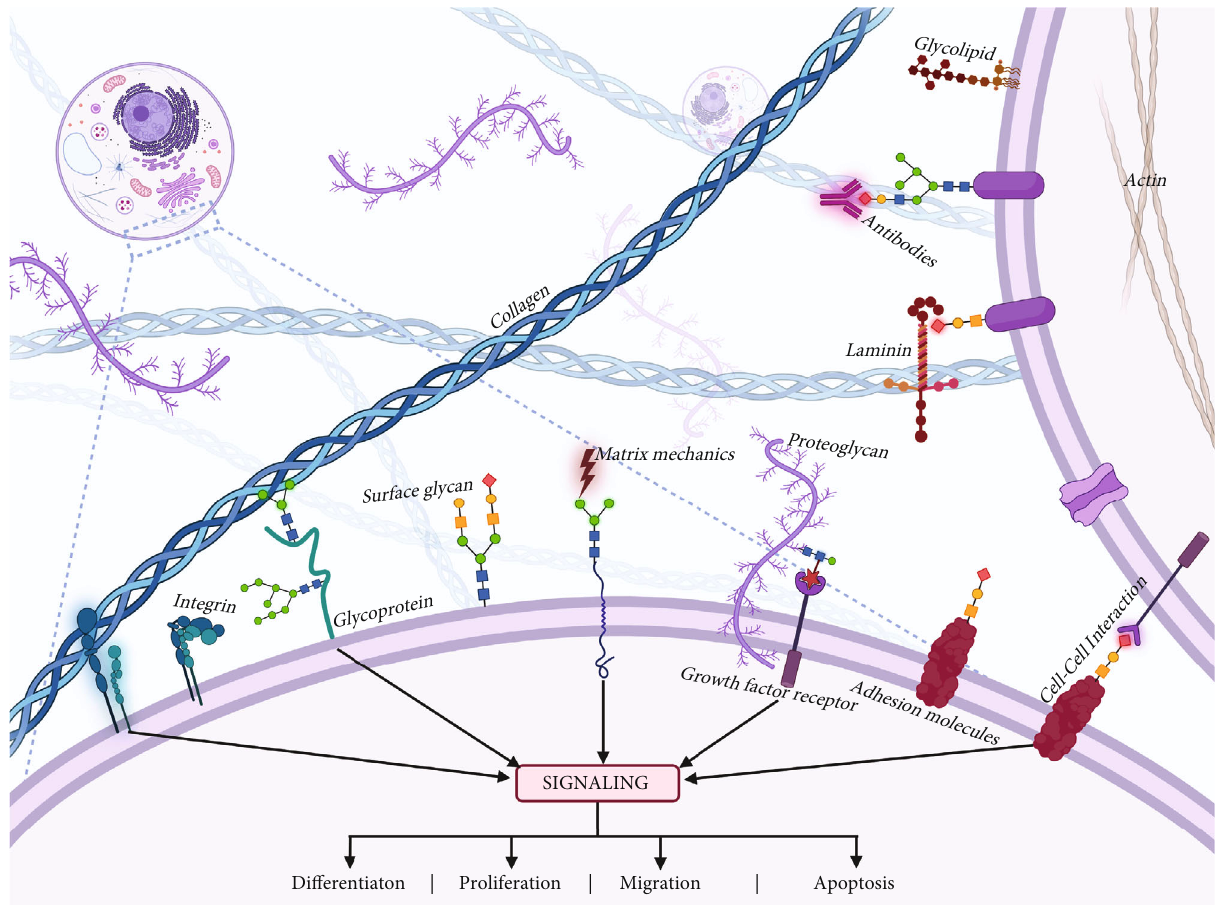
Figure 1: Interactions in the microenvironment. Cells reside in a dynamic environment consisting of ECM components, adjacent cells, mechanical forces, and various biological cues. The cell membranes o ff er platforms for cellular activities within their microenvironment, including molecule recognition, cell-cell interaction, and cell-matrix combination, which will, respectively, lead to di ff erent cell fates. Cell-surface glycans wrapped the membranes of cells and mediated those interactions in the